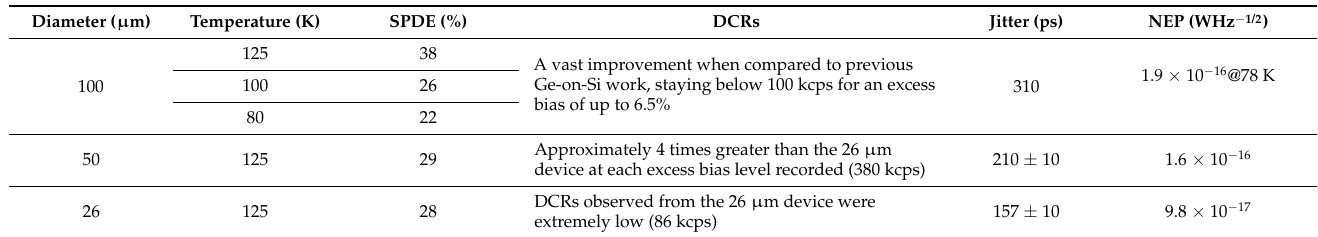
Figure 22. Comparison of afterpulsing probabilities vs. gate delay time between planar Ge/Si SPAD (100 µ m diameter) with commercial InGaAs/InP SPAD (25 µ m diameter). Reproduced from [78], Springer Nature, open access, 2019. Table 2. Summarized device performance for planar geometry Ge/Si SPAD at 1.31 µ m